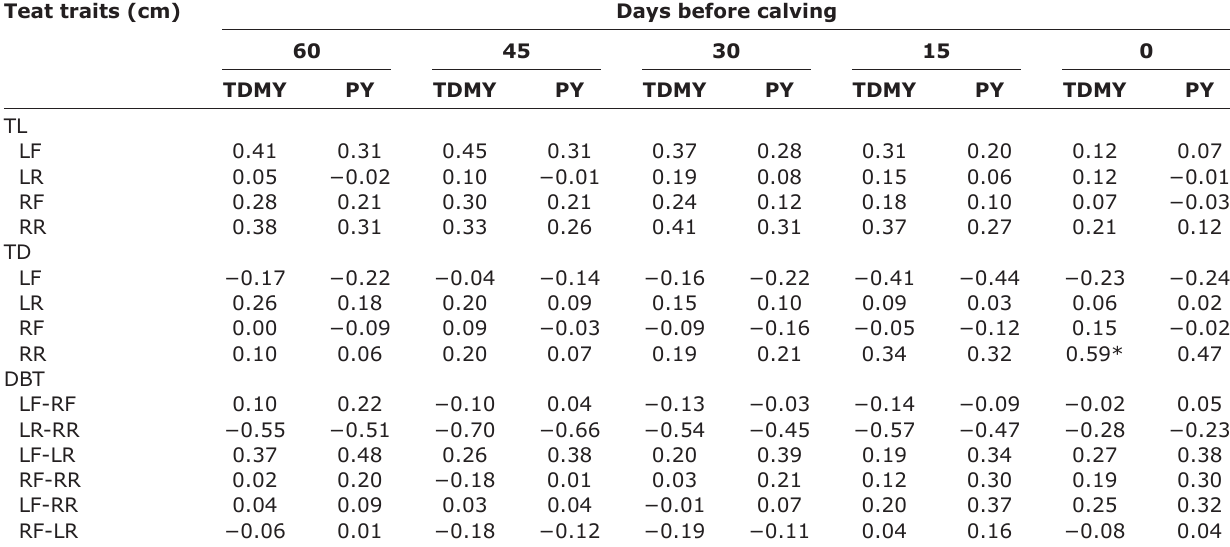
Table-4: Correlation coefficients of teat traits with TDMY and PY at different days of pregnancy in primiparous Nili-Ravi buffaloes. Teat traits